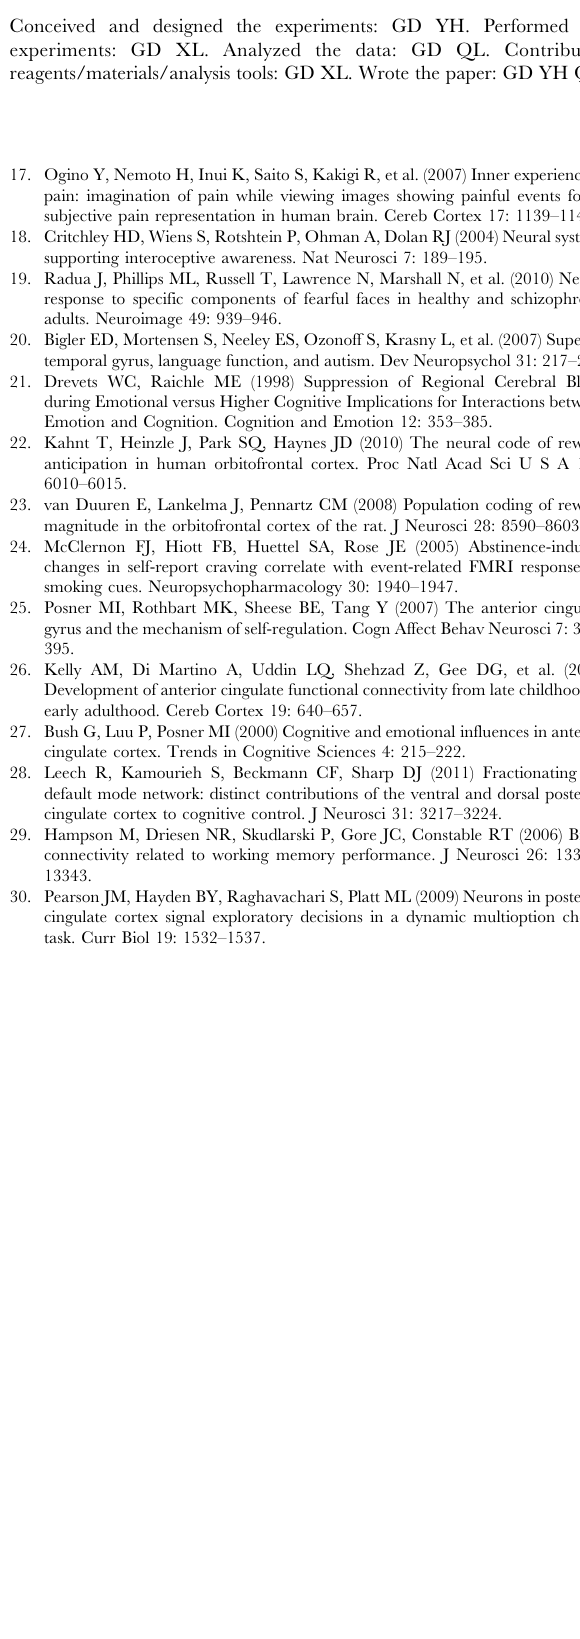
Table S1 The self-reported emotion experience ques-